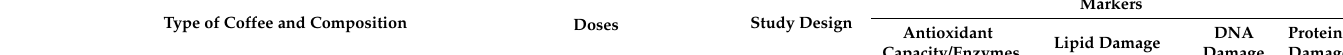
Markers Antioxidant Protein Lipid Damage DNA Damage Capacity/Enzymes